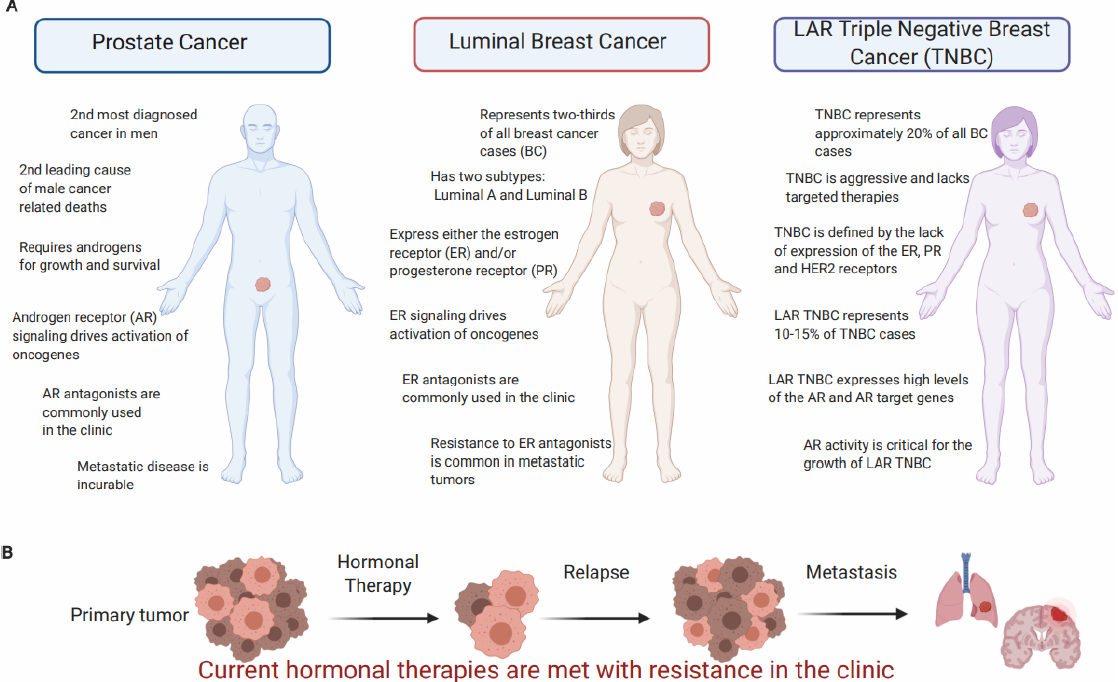
Figure 2. Challenges in Hormone-Dependent Prostate and Breast Cancers. ( A ) An overview of the clinical challenges for hormone-dependent prostate cancer, luminal breast cancer, and LAR (luminal androgen receptor) triple-negative breast cancer. ( B ) Resistance to hormonal therapies is a critical clinical challenge after patients relapse on therapy, as depicted in the diagram.